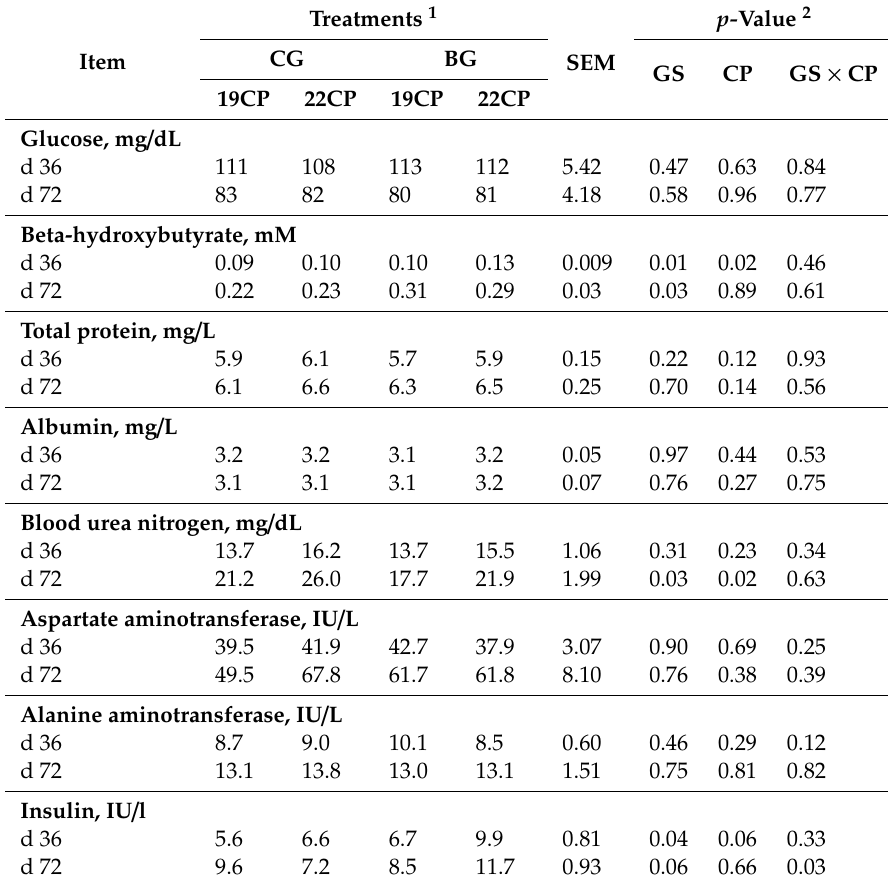
Table 5. Least square means for blood metabolites, liver enzymes, and insulin in dairy calves fed di ff erent grain sources (corn grain vs. barley grain) and di ff erent protein levels (19% vs. 22 % of DM) ( n = 10 calves per